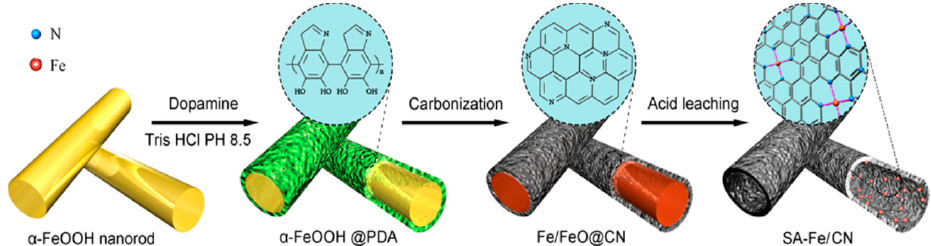
Figure 1. Synthetic procedure for SA-Fe/CN. Reprinted with permission from Ref [16]. Copyright 2017, American Chemical Society.